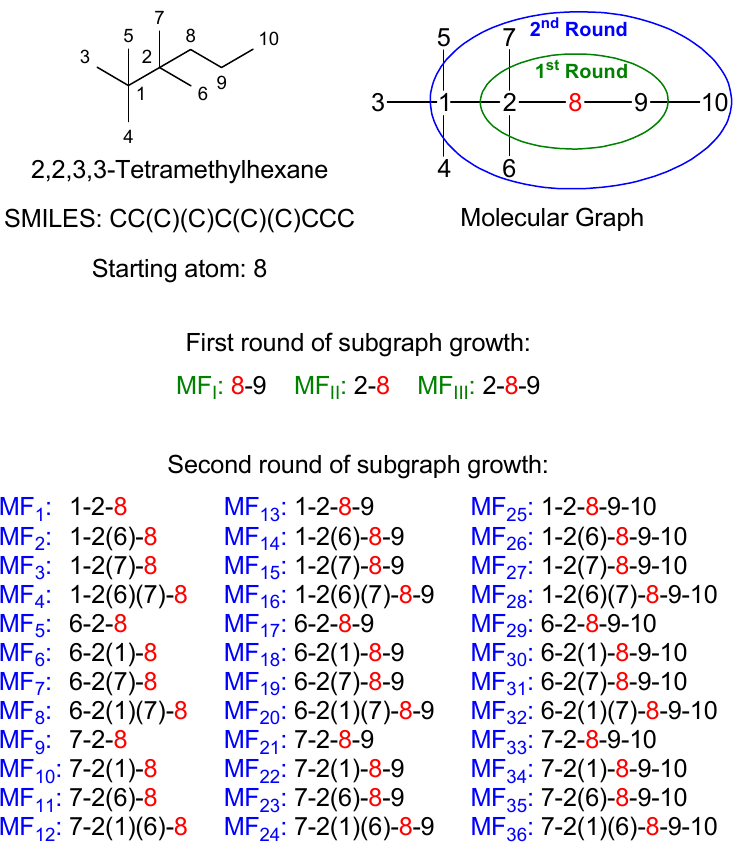
Figure 2. Subgraph engendering process. Starting at atom 8, the first fragment growth round produces three subgraphs by including the neighbors of atom 8. The second growth round includes the neighbors of atom 2 and 9 producing additional 36 subgraphs.